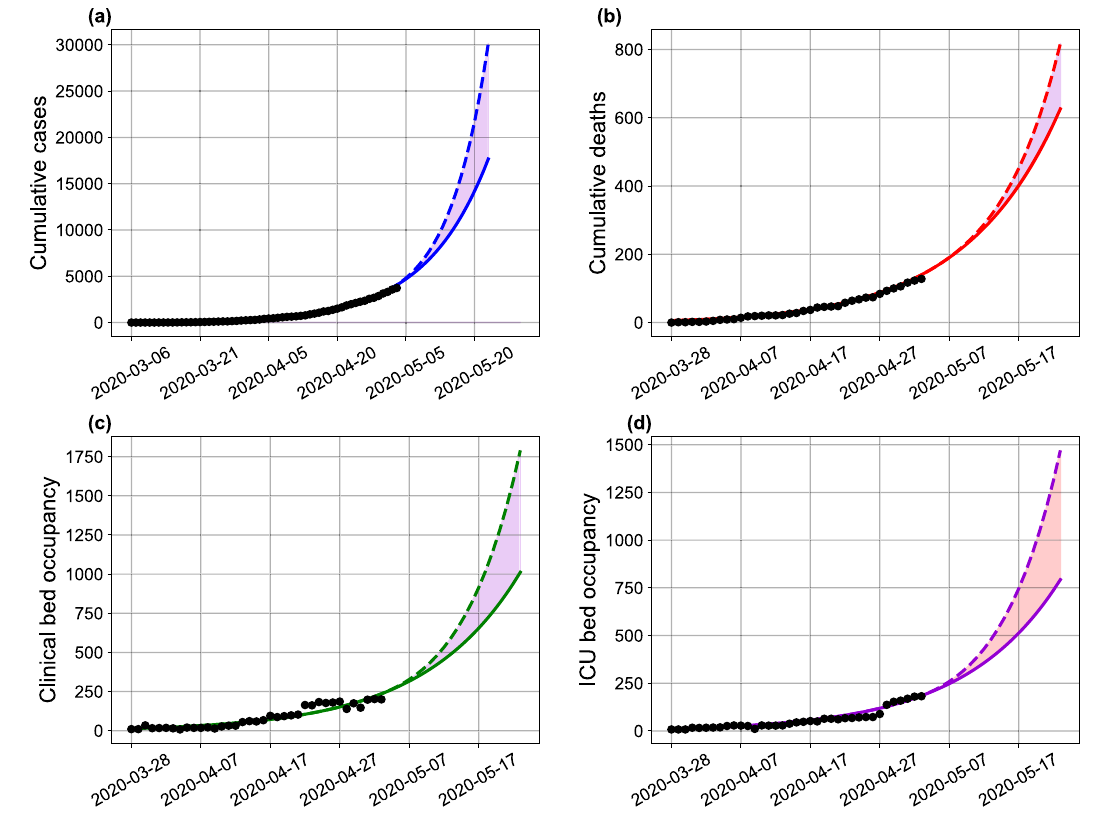
Fig. 4 Effect of easing the social distancing for individuals with asymptomatic/mild infections in Bahia. Impact on the ( a ) number of cases, ( b ) deaths, ( c ) clinical hospitalization, and ( d ) ICU bed requirements at the state level. Here, the value of δ has been increased by 50% ( δ = 0.51 in this simulation). The black dots correspond to the actual number of cases ( a ), deaths ( b ), and hospital bed occupancy ( c ) – ( d ). The assumed parameter values are shown in Supplementary Table 3. Raw data from March 6 to May 4, 2020 are shown in this graph.